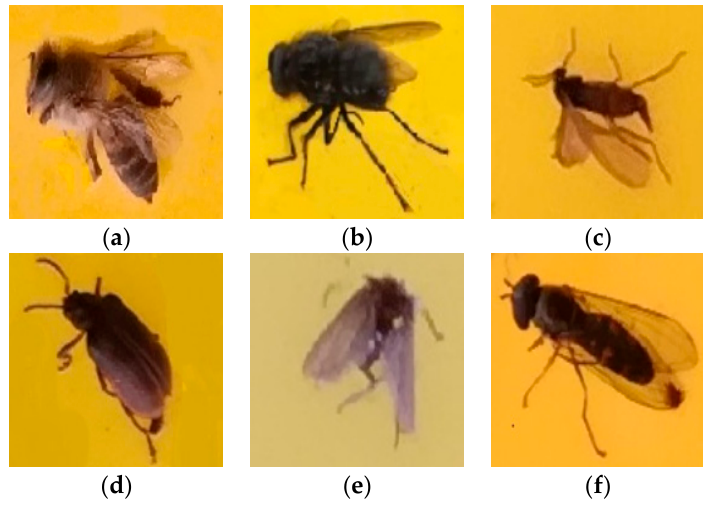
Figure 7. Flying insect images ( a ) Bee; ( b ) Fly; ( c ) Mosquito; ( d ) Chafer; ( e ) Moth; ( f ) Fruit fly.